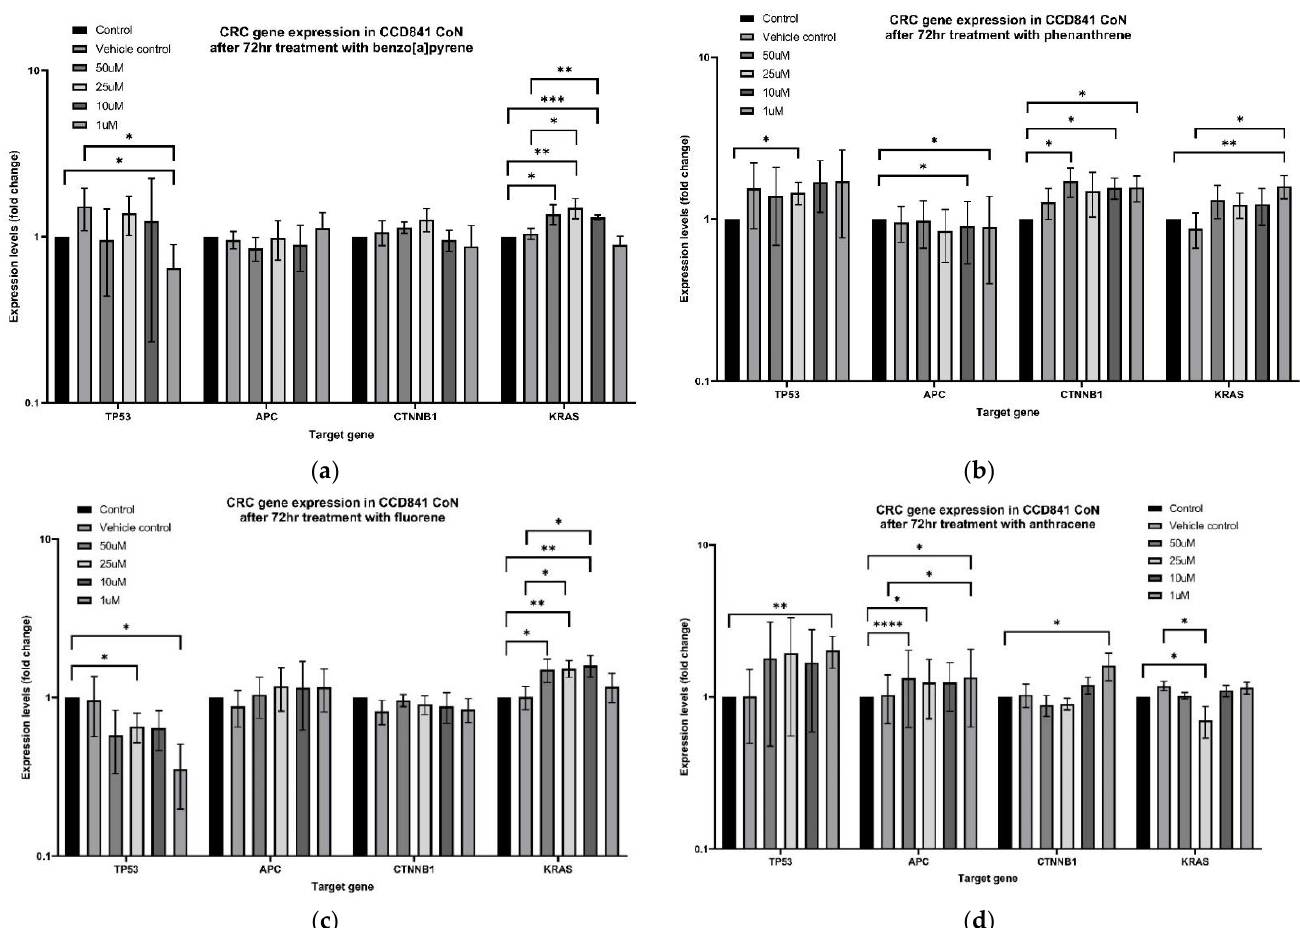
Figure 2. mRNA expression changes of TP53 , APC , CTNNB1 , and KRAS in CCD841 CoN cell line after 72-h treatment with ( a ) B[a]P; ( b ) PHEN; ( c ) FLU; and ( d ) ANTH. Statistical significance was considered at p > 0.05. * = p < 0.05; ** = p < 0.01; *** = p < 0.001; **** = p < 0.0001.